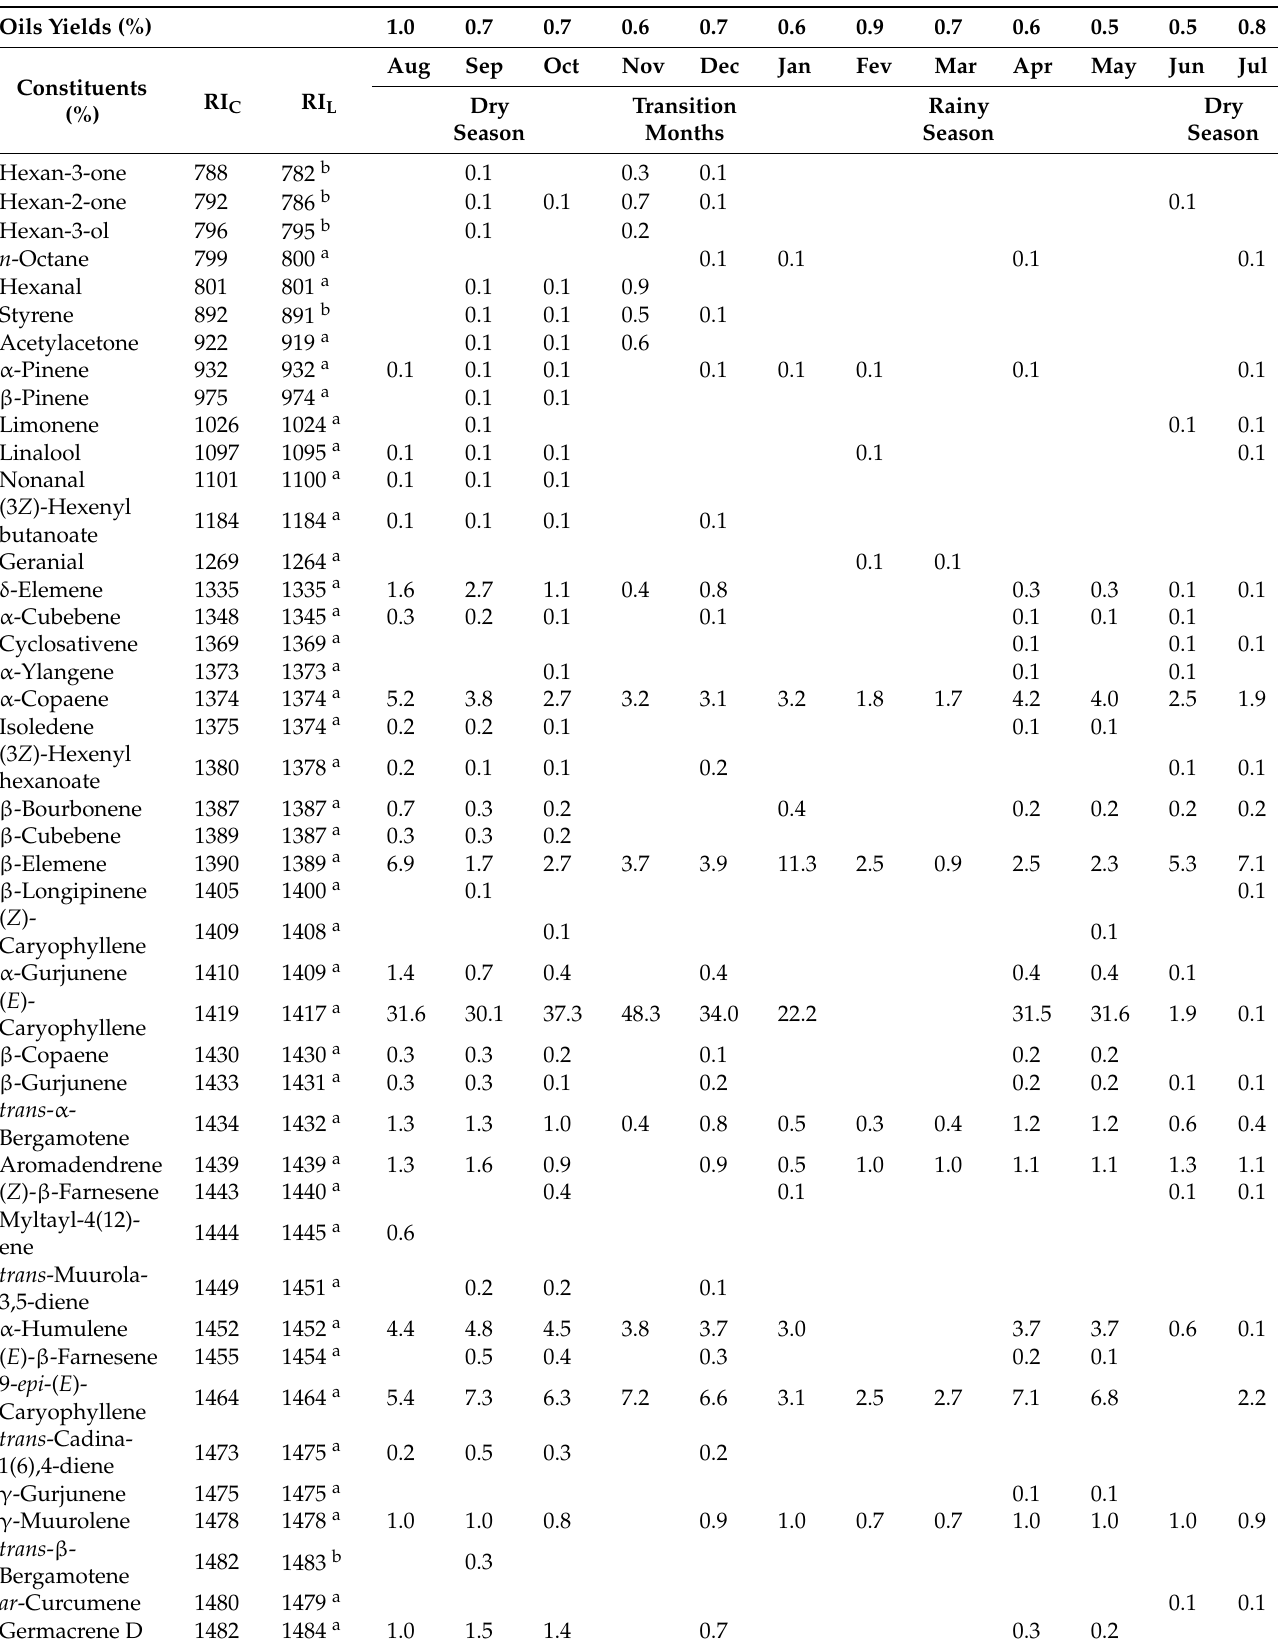
Table 1. Seasonal variability of the leaf essential oil of Eugenia patrisii : yields and oils